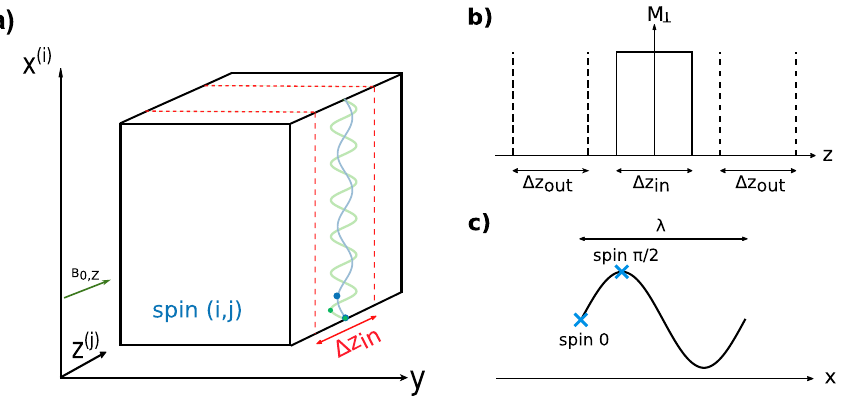
Figure 1. ( a ) Experimental setup: the shear wave propagates in the phantom along the x-axis. The motion sensitizing direction is fixed to the slice gradient direction. ( b ) An axial slice is acquired with a corresponding bandwidth Δz in and controlled outbands Δz out along the z-axis, all of which are discretized. ( c ) Isochromats are discretized along the shear wave propagation direction (x-axis) and are defined by θ i = 2πx i /λ with x i representing a specific